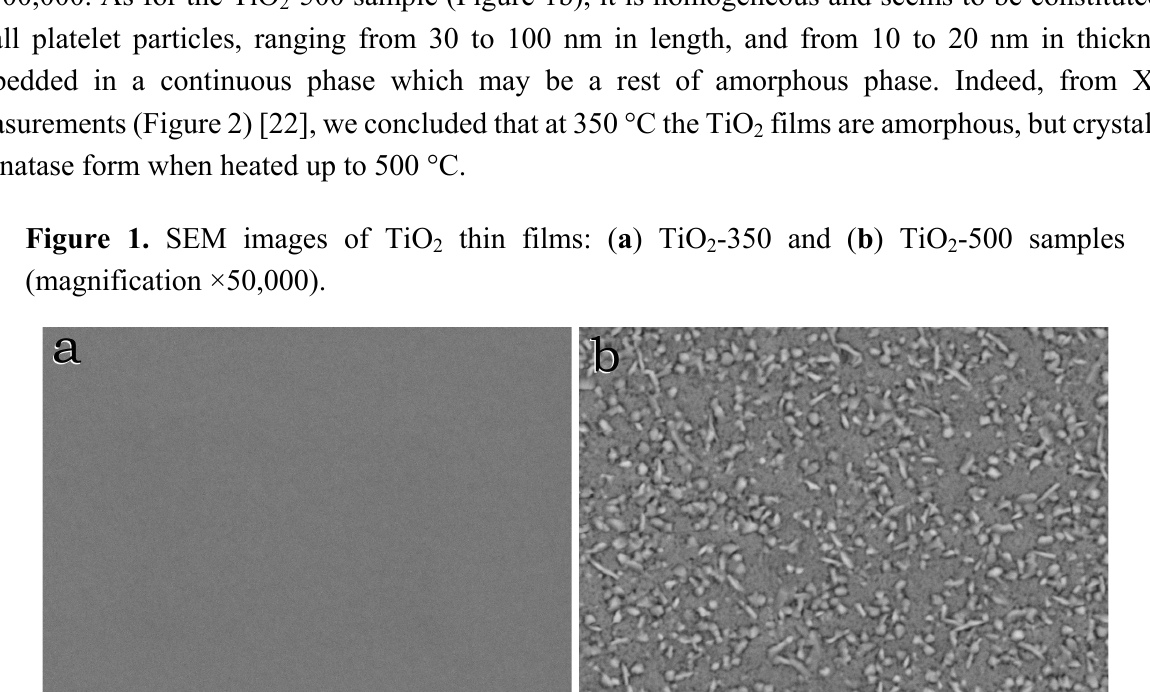
-500 sample and commercial powder as a 2